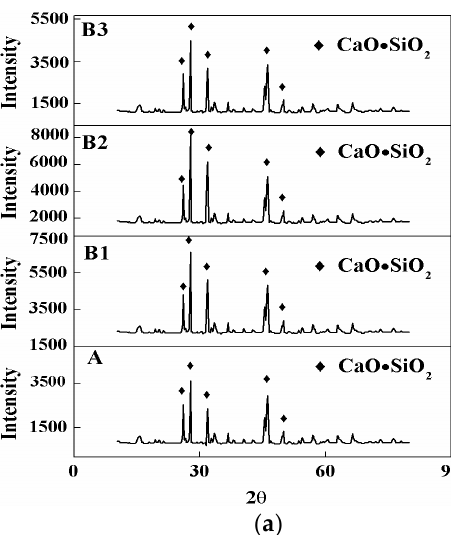
Figure 6. Crystalline phases of the slag films at different temperatures: ( a ) T = 1473 K and ( b ) 1273